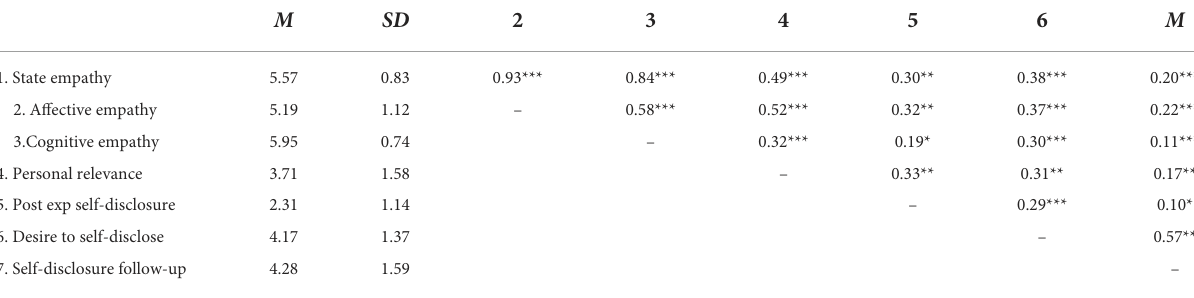
TABLE 2 Descriptives and correlations for the main study variables in Study 2.